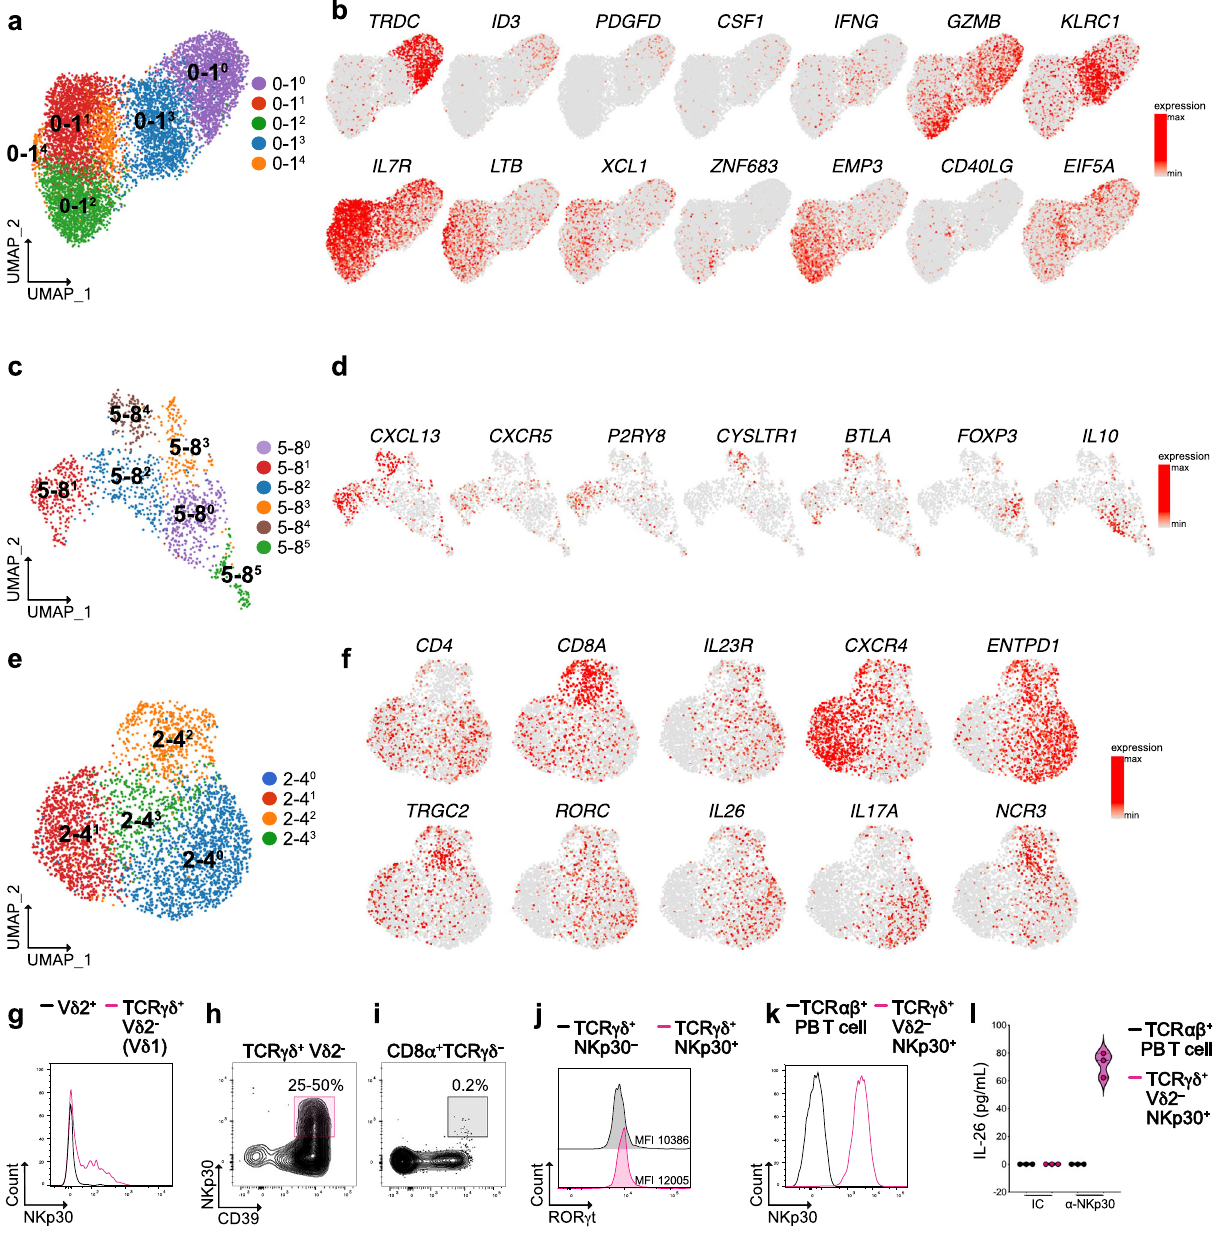
Fig. 4 Reclustering of heterogenous IEL CD8 + and CD4 + T cells populations. a Unsupervised UMAP reclustering of clusters 0 and 1 from Fig. 1a. b UMAP of representative selected genes associated with the identi fi ed clusters. c Unsupervised UMAP reclustering of clusters 5 and 8 from Fig. 1a. d UMAP of representative selected genes associated with the identi fi ed clusters. e Unsupervised UMAP reclustering of clusters 2 and 4 from Fig. 1a. f UMAP of representative selected genes associated with the identi fi ed clusters. g Overlay expression of NKp30 in V δ 2 – (pink) vs. V δ 2 + (black) γδ T cells. h , i Representative fl ow plots showing the expression of NKp30 in TCR γδ + V δ 2 – CD39 + ( h ) and CD8 + TCR γδ – CD39 + ( i ). T cells in terminal ileum of control patients (one donor representative of nine is shown). j Overlay expression of ROR γ t in NKp30 – (black) vs. NKp30 + γδ T cells (pink). k Overlay expression